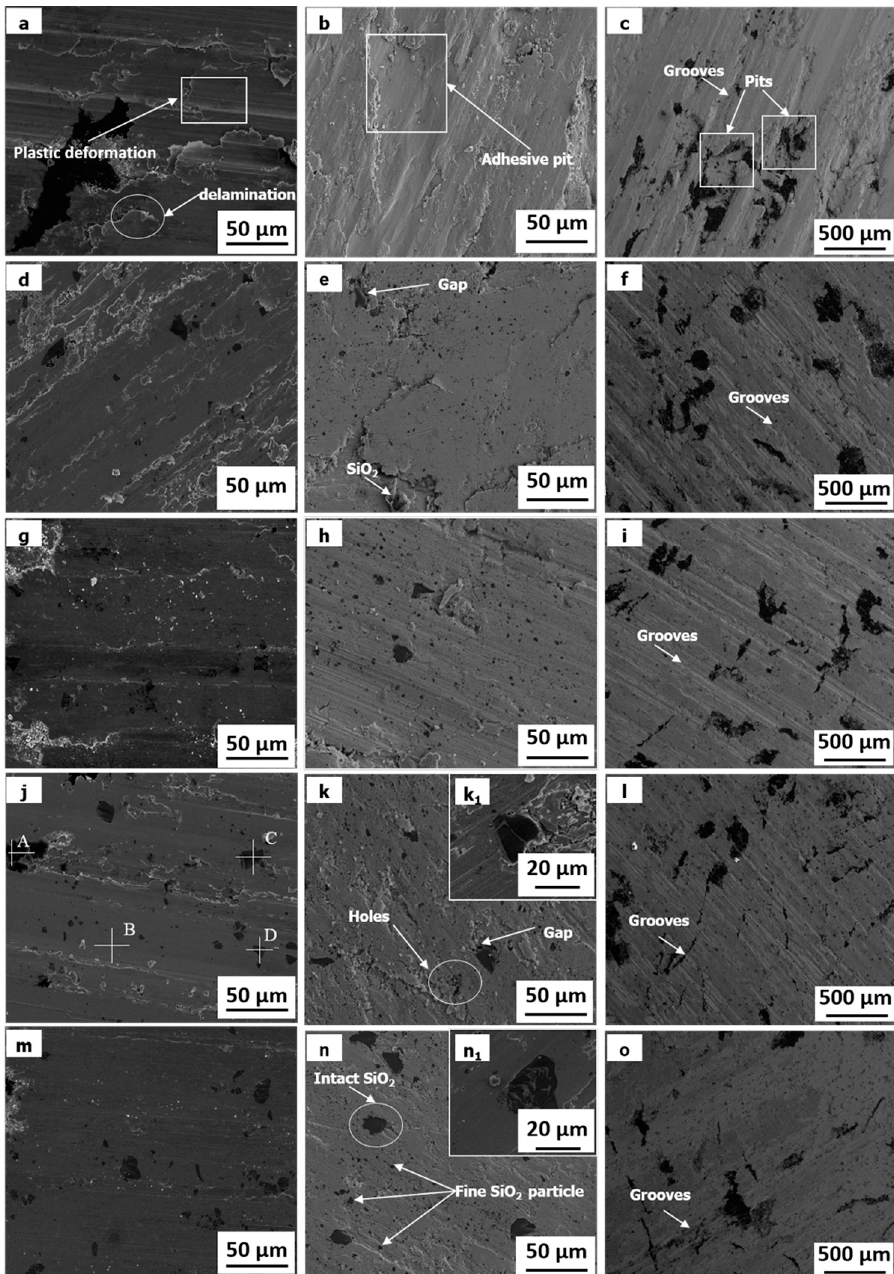
Figure 6. SEM morphologies of the worn surfaces of 0S ( a , b , c ), 1S ( d , e , f ), 1S-Cu ( g , h , i ), 3S ( j , k , k1 , l ), and 3S-Cu ( m , n , n1 , o ) at sliding speed of 3 m/s and applied load of 0.4 MPa ( a , d , g , j , m ) and 0.8 MPa